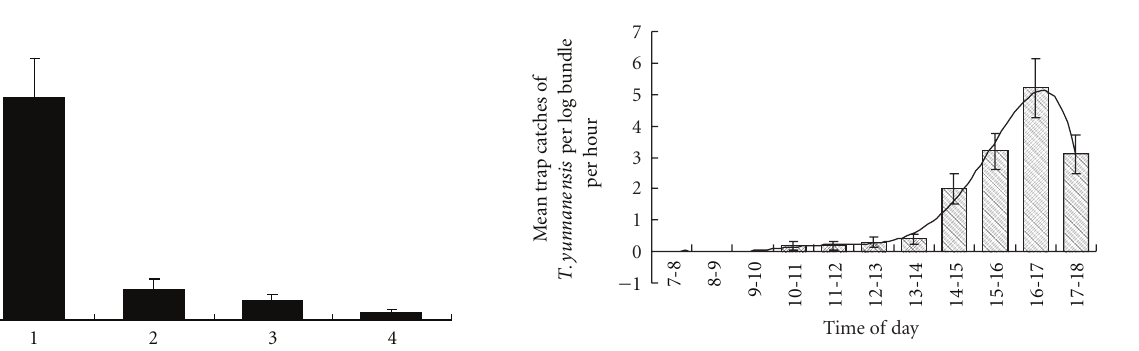
Figure 2: Daily mean trap catches ( ± SE, N = 180) of T. yunna- nensis attracted to: (1) periderm peeled logs, (2) periderm and phlo- em peeled logs, (3) intact (unpeeled) logs, and (4) standing peri- derm-peeled Yunnan pines (Dec.–Feb. 2006, 2007; Qujing, Yunnan, China).